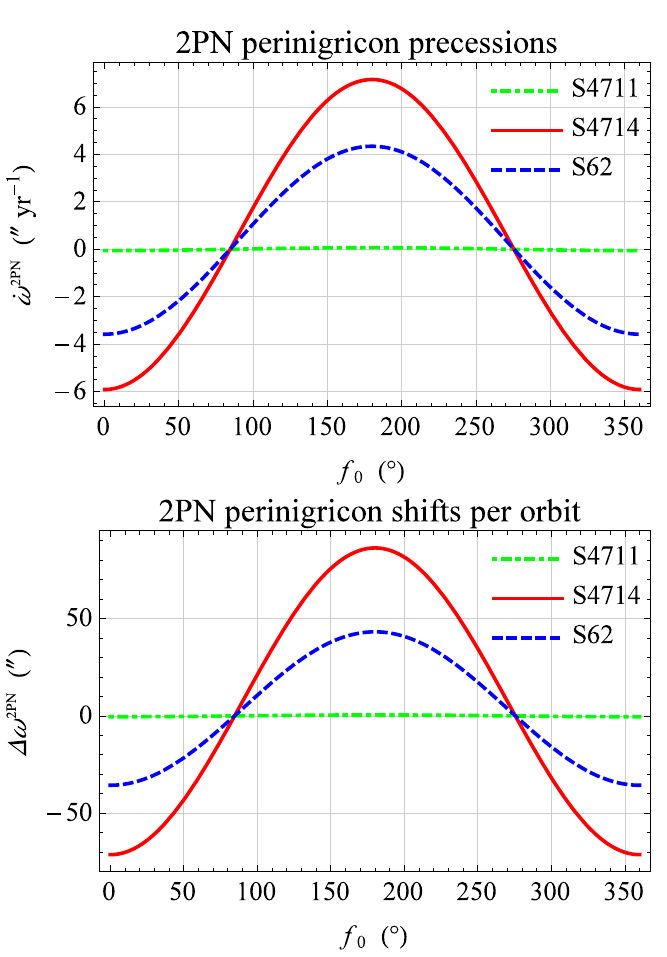
Figure 1. Upper panel: plot of the 2PN perinigricon precessions ˙ ω 2PN of the S-stars S4711, S4714, and (cid:0) (cid:48)(cid:48) (cid:1) S62 [13] in arcseconds per year yr − 1 as a function of the true anomaly f 0 at the epoch according to Equation(8). Lower panel: plot of the 2PN perinigricon shifts per orbit ∆ ω 2PN = 2 π / n b ˙ ω 2PN of the S-stars S4711, S4714, and S62 [13] in arcseconds ( (cid:48)(cid:48) ) as a function of the true anomaly f 0 at the epoch according to